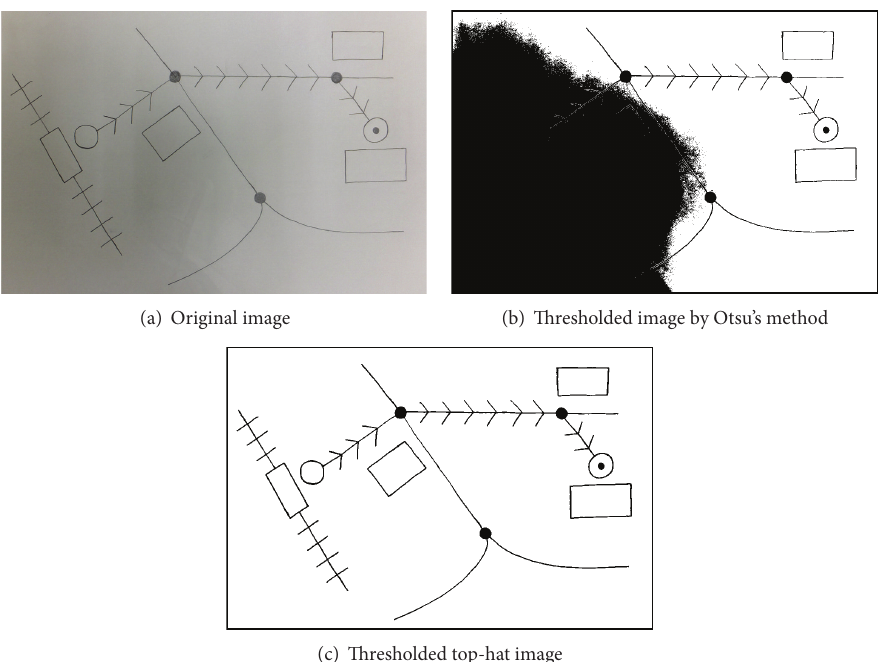
Figure 4: Using the top-hat transformation for shading correction, the top-hat transformation corrects the effects of nonuniform illumination, and, as a result, the fine binary image is created using Otsu’s